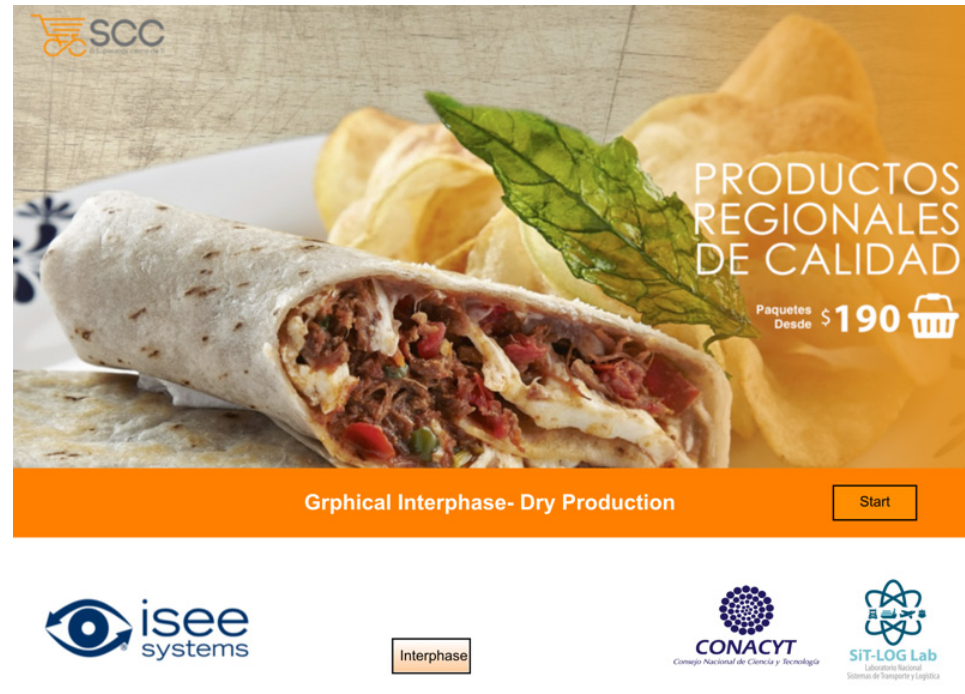
Figure 10. Graphical interface-main page.